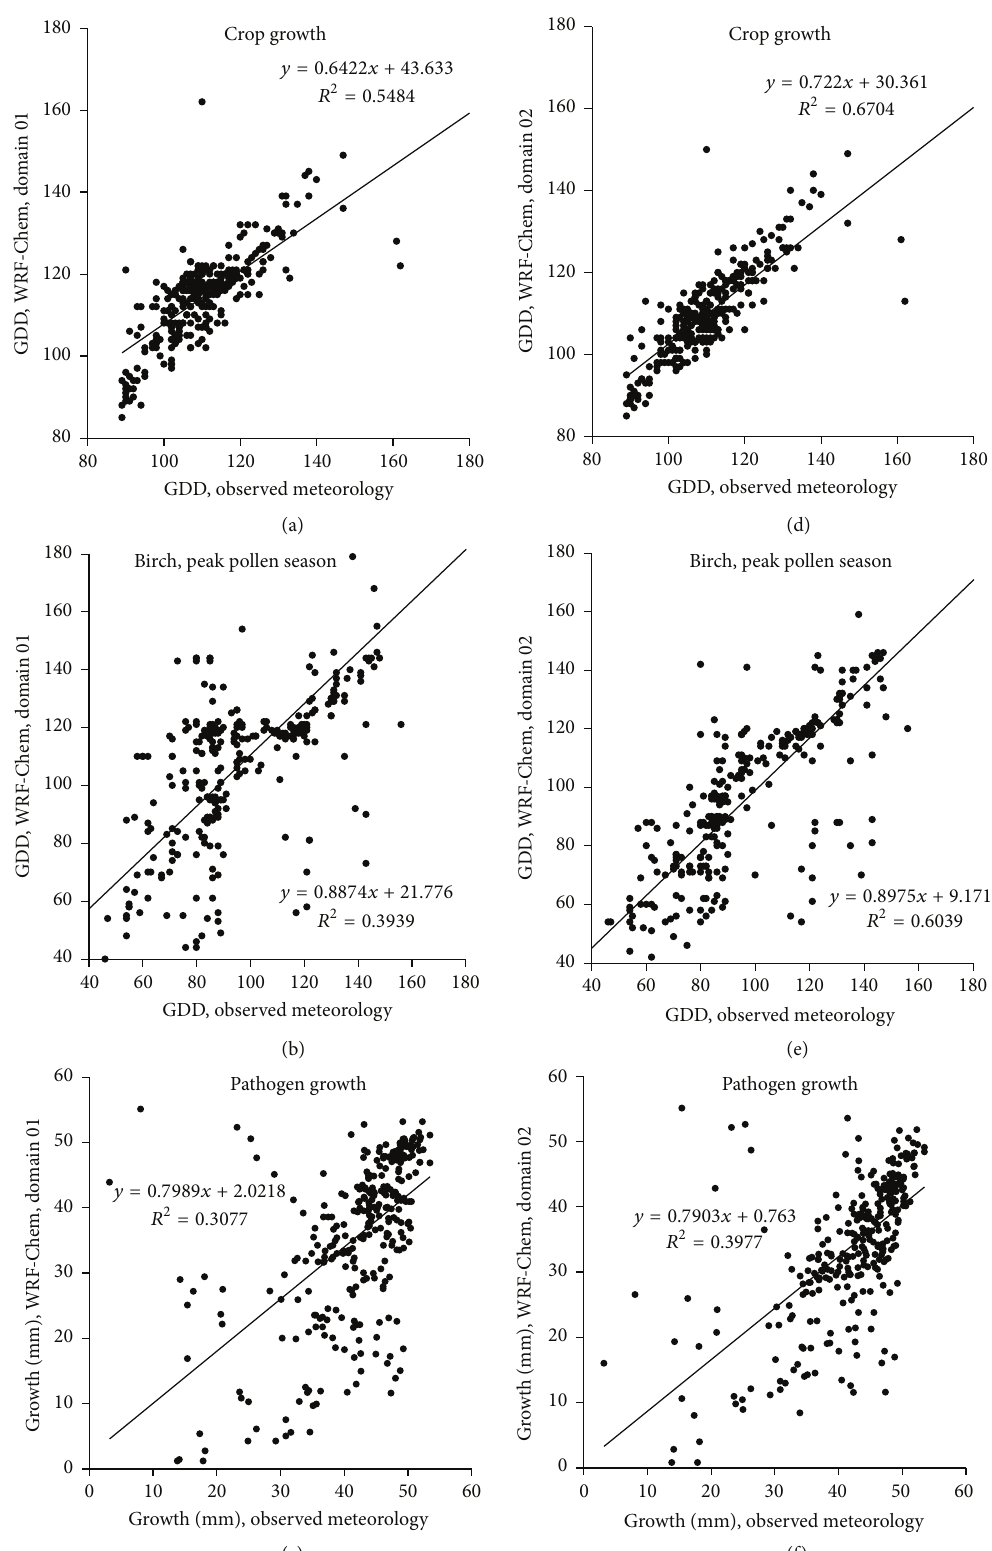
Figure 5: Simulation of crop growth ((a) and (d)), pollen season ((b) and (e)), and pathogen growth ((c) and (f)) using observations and model results at selected sites in central-northern Europe. First column corresponds to WRF-Chem simulations with 36km resolution and second column to WRF-Chem simulations with 12km